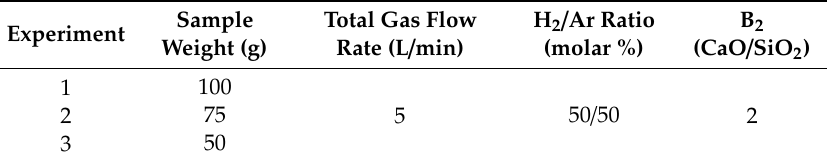
Table 2. Experimental program.